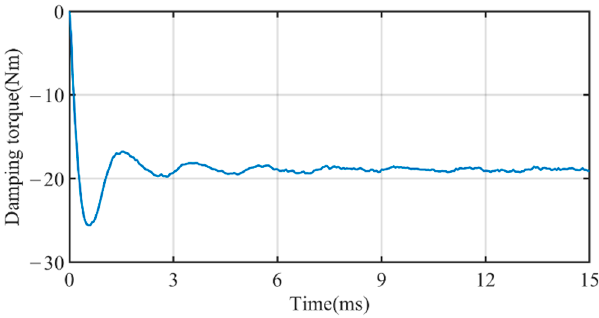
Figure 12. Output damping torque of the electromagnetic damper.